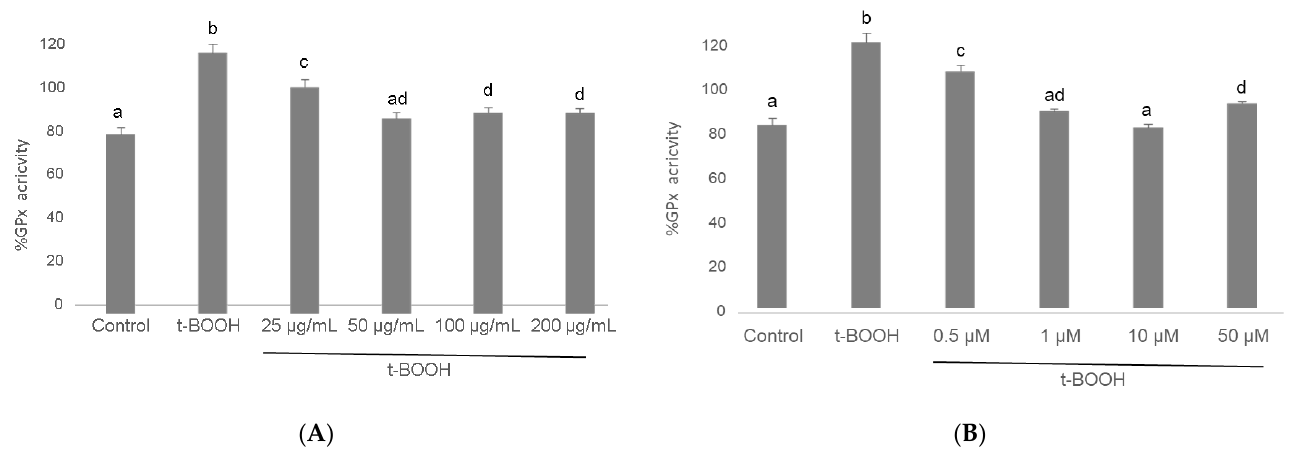
Figure 6. Effect of pre-treatment of differentiated SH-SY5Y cells with cocoa extract ( A ) and EC ( B ) prior to oxidative stress on GPx activity. Values are means ± SD, n = 3. Values are expressed as a percent relative to the control condition. Different letters indicate statistically significant differences ( p < 0.05) among groups.